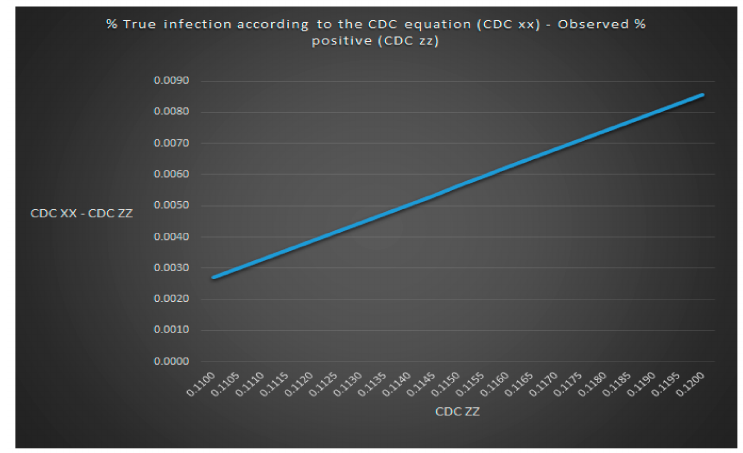
Figure 8. The value of observed % positive cannot be equal to predicted % positive for the average scenario in the CDC model.